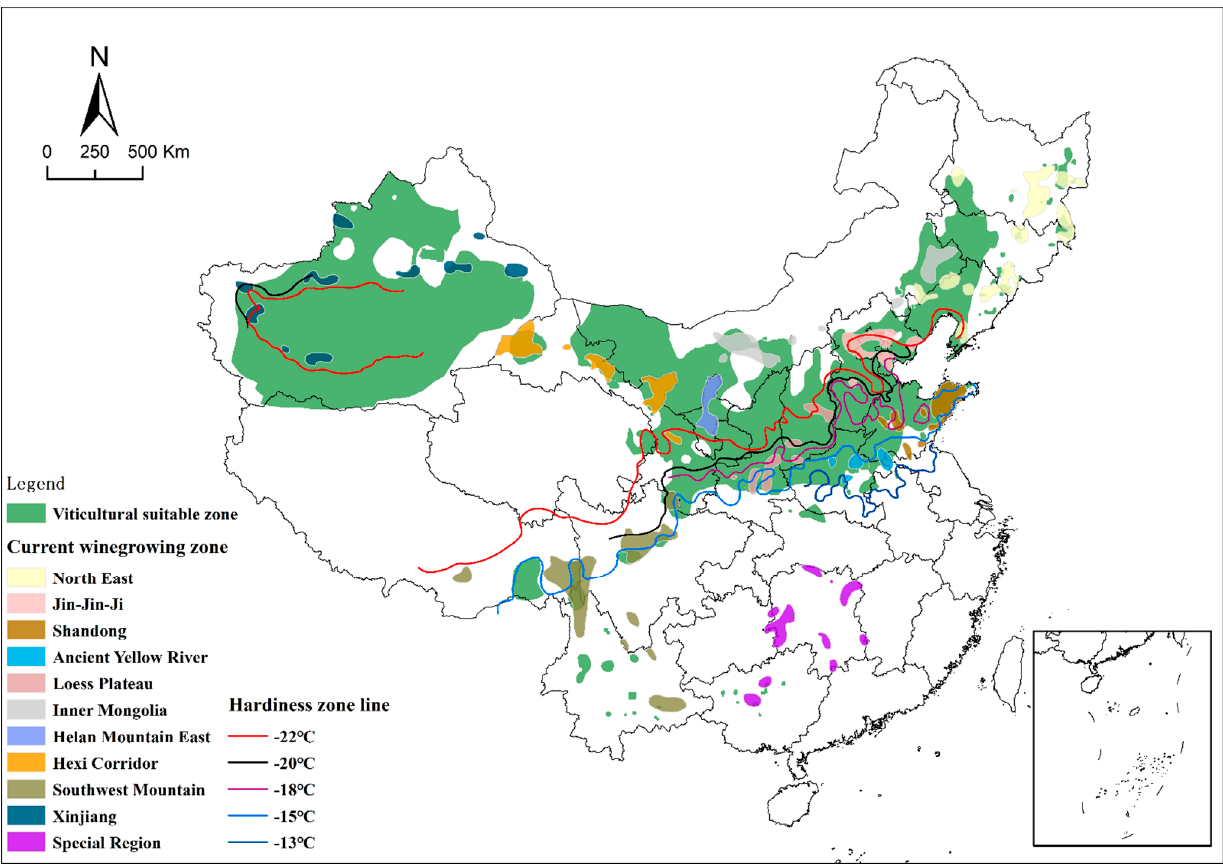
Figure 3. Cold regionalization of wine grape ( V. vinifera ) in China. Five isotherms divide wine grape germplasm ( V. vinifera ) into four cold regions. Region A, region B, region C, and region D correspond to temperature ranges of − 22 °C ≤ LT 50 ≤ − 20 °C, − 20 °C ≤